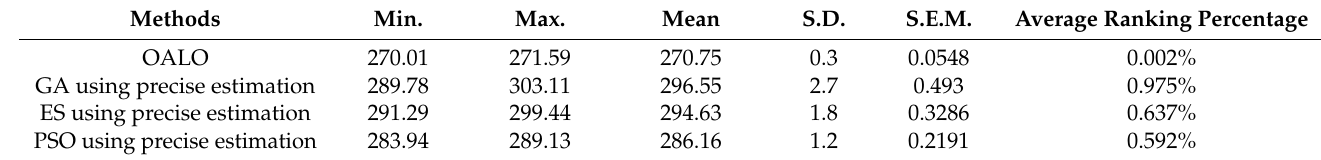
Table 5. Statistics obtained by four methods over 30 simulation